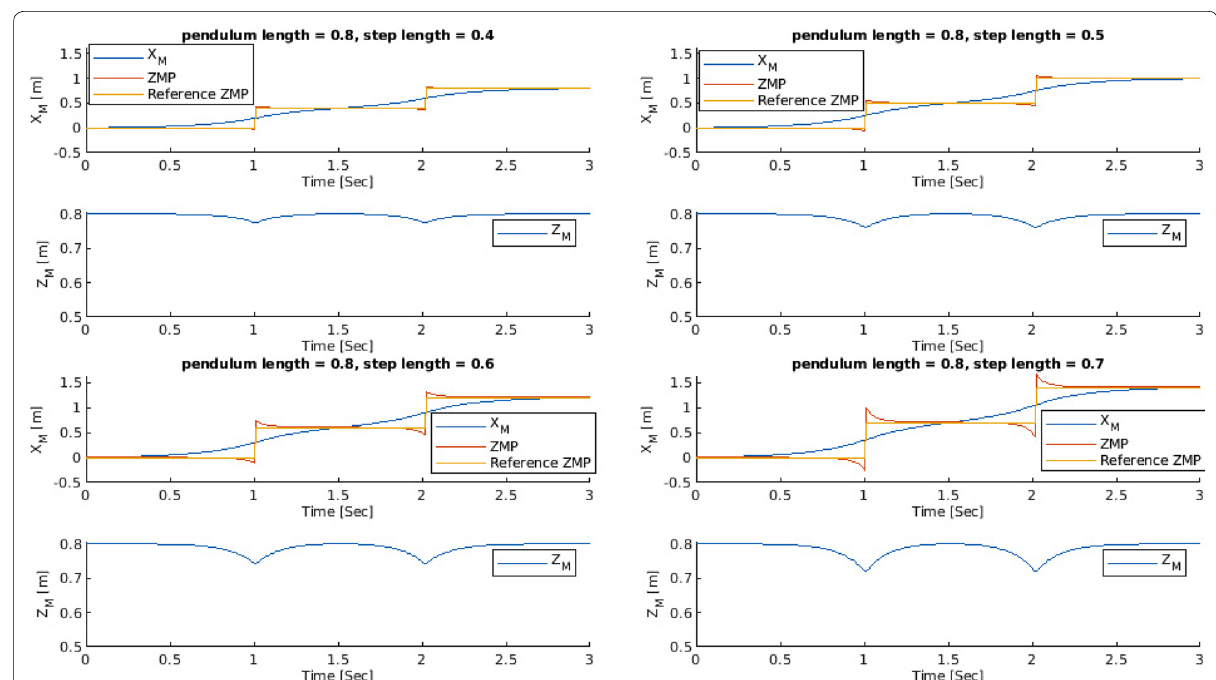
Fig. 3 Example of ZMP planning using a nonlinear inverted pendulum